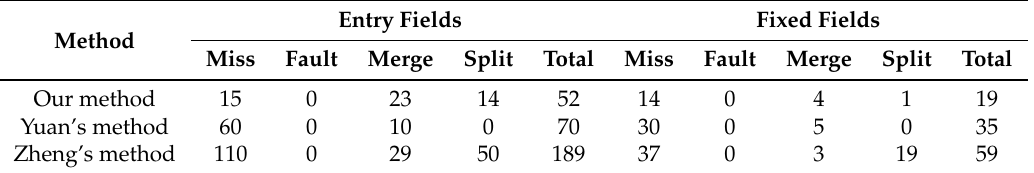
Table 3. Numbers of every Error types in obvious case of trapezoid.